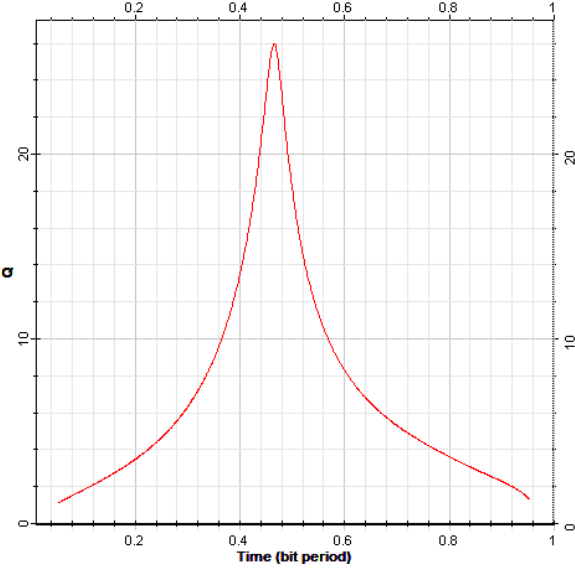
Figure 10. BER analyzer for the XOR gate.